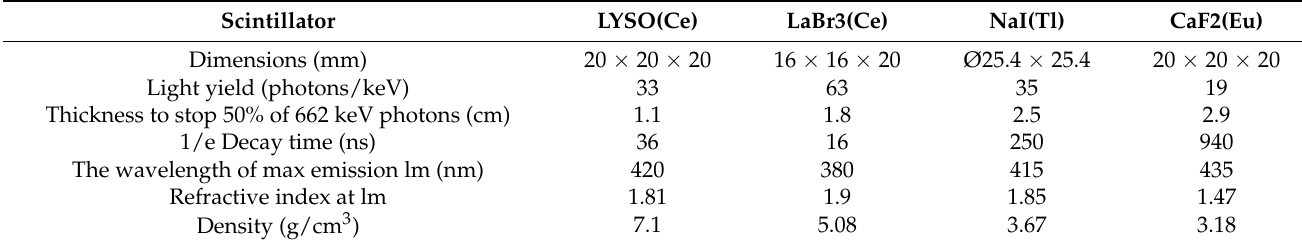
Table 3. The scintillation materials used to measure ionising radiation.